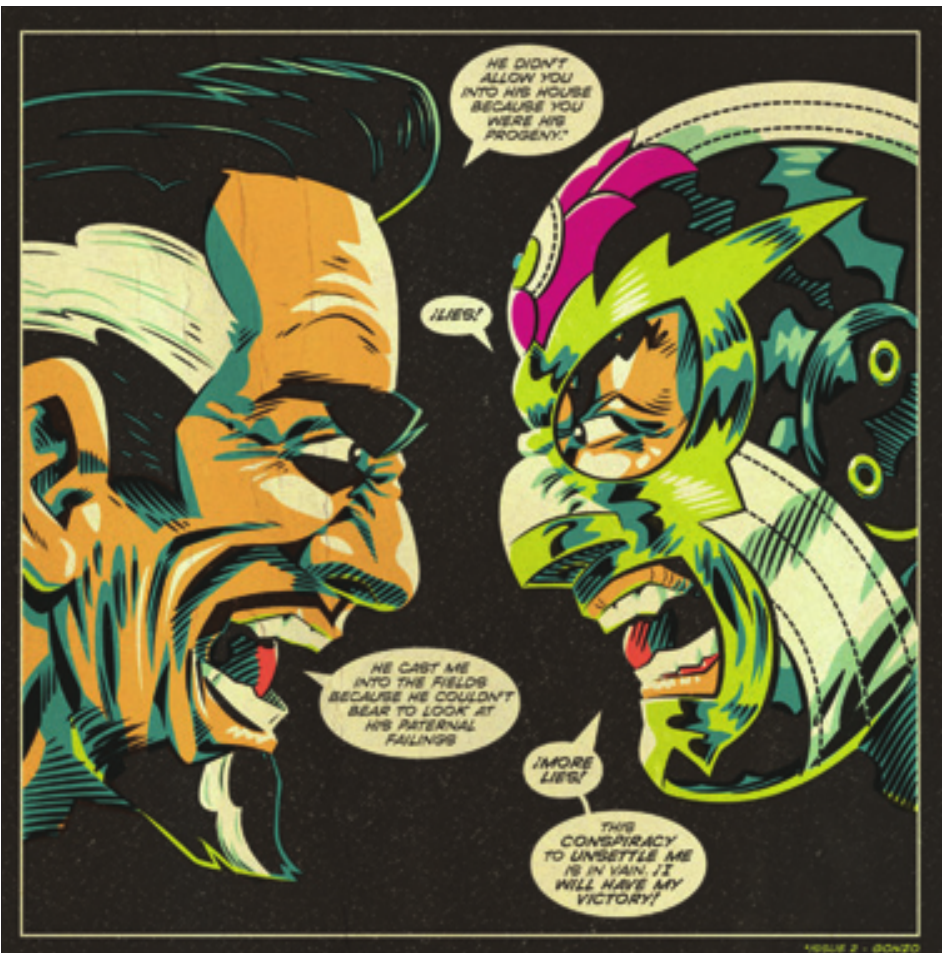
Figure 6 Monchi’s confrontation in J. Gonzo’s La Mano del Destino